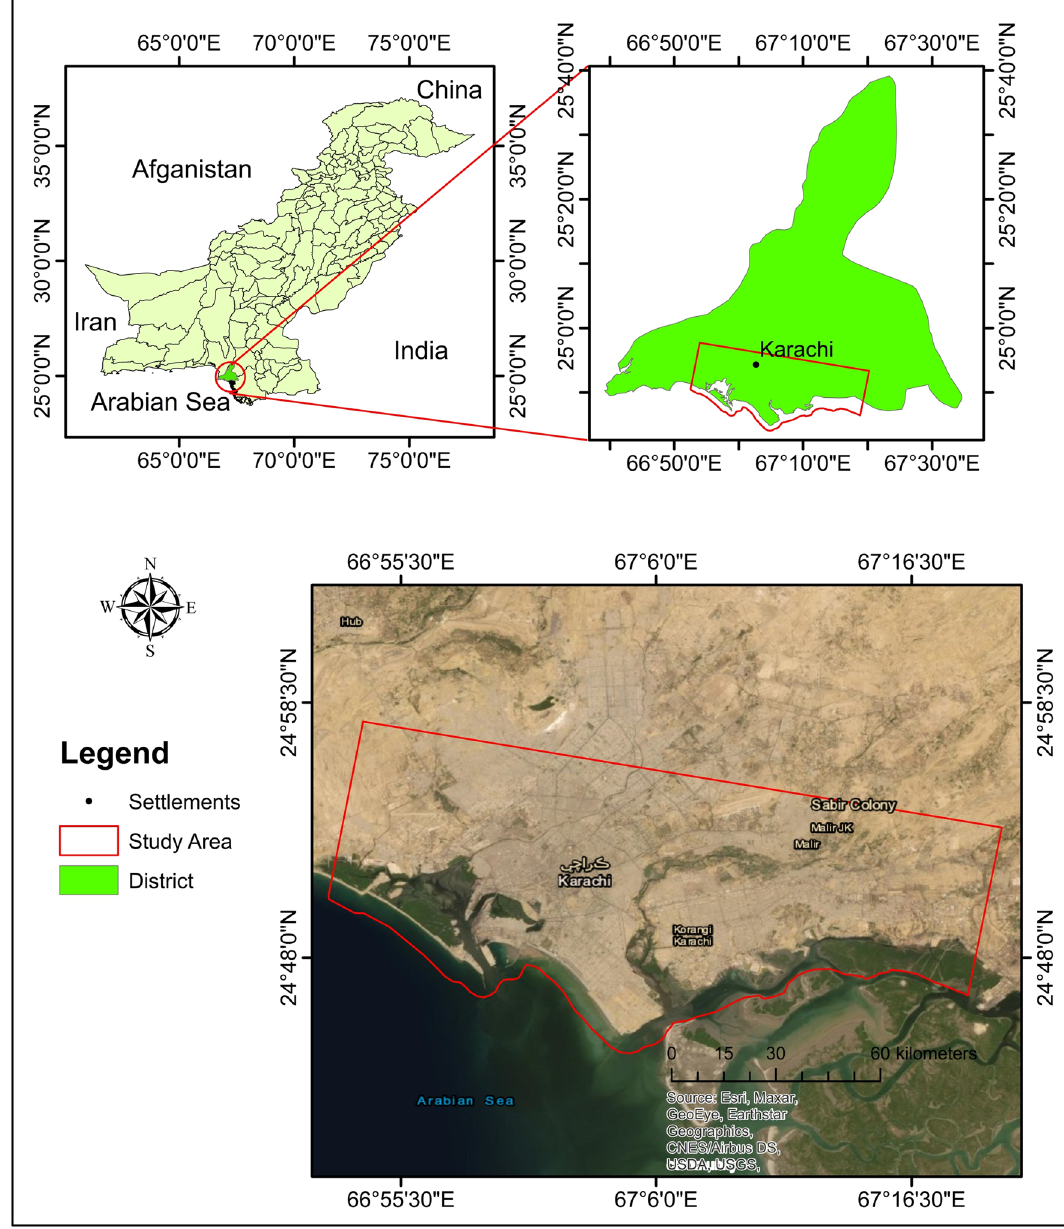
Figure 1. The geographical location of the study